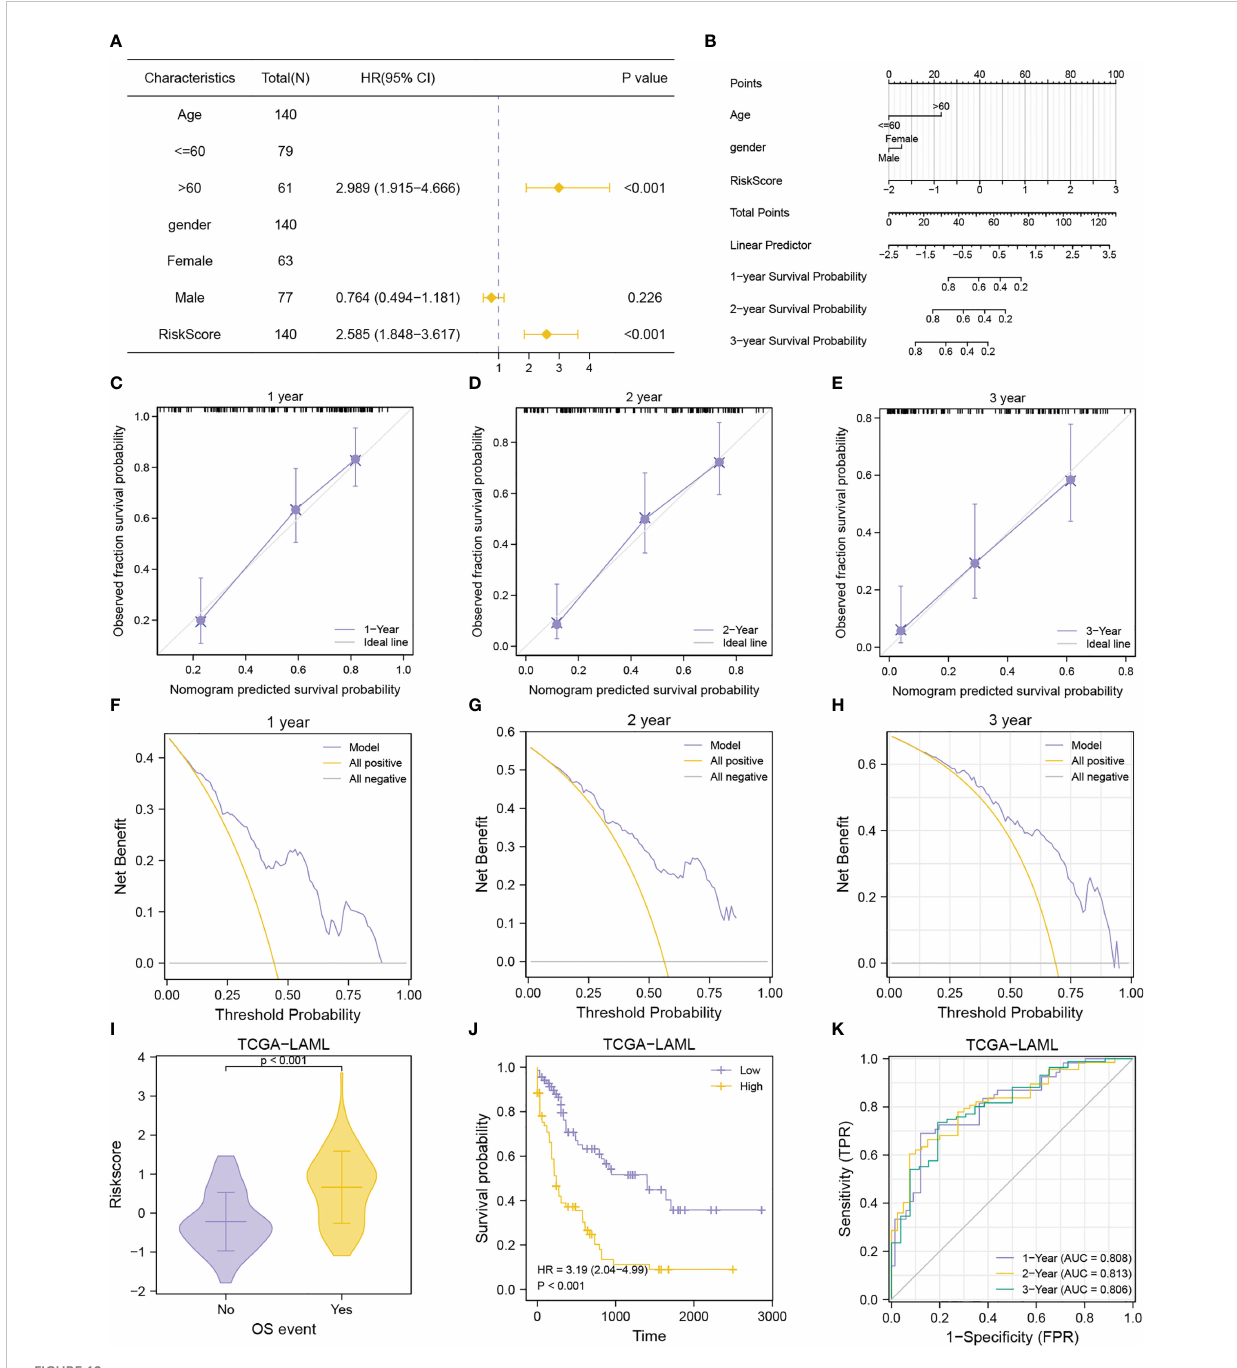
FIGURE 12 Prognostic performance of the MMRGs prognostic model. (A, B) . Forest plot (A) , nomogram (B) of multivariate Cox regression model with risk score and clinical variable. (C-E) . Calibration curves of multivariate Cox regression model nomogram for the 1-year (C) , 2-year (D) , and 3-year (E) outcomes. F-H. DCA plots of multivariate Cox regression model for the 1-year (F) , 2-year (G) , and 3-year (H) outcomes. (I-K) . Comparison of OS events (I) , prognostic KM curve (J) , and time-dependent ROC curve (K) of the risk score + age + gender prognosis